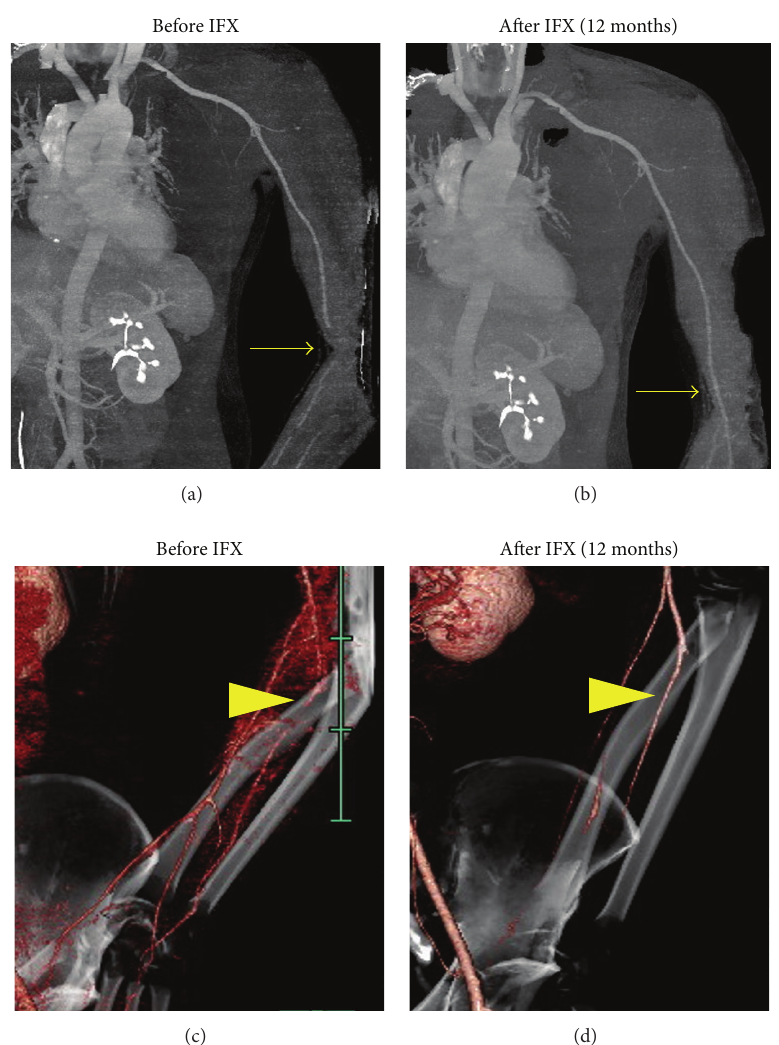
Figure 2: Computed Tomography Angiography showed severe stenosis of left brachial (a) and radial (c) arteries before infliximab (IFX) induction. After IFX therapy, the artery stenosis was immediately resolved and sustained clinical remission ((b) and (d) at 12 months since IFX was